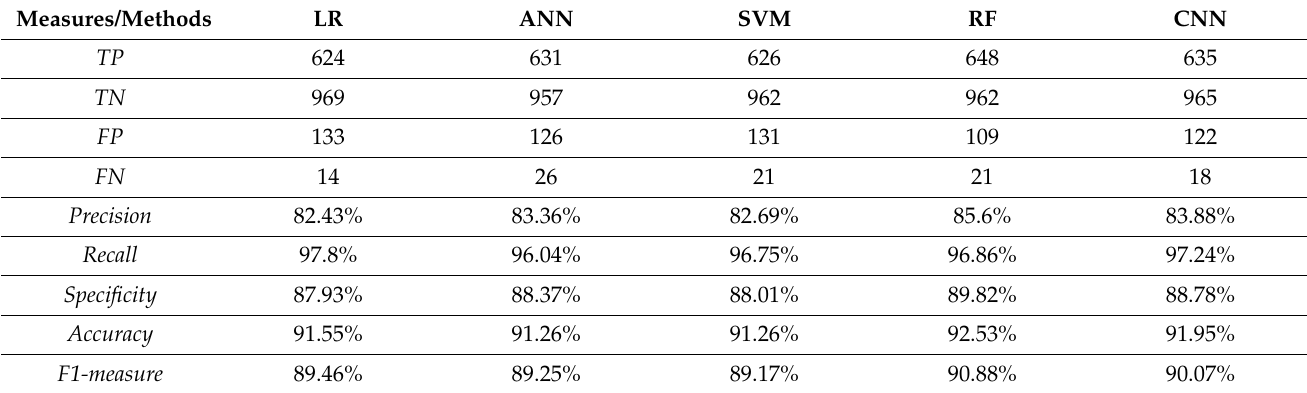
Table 2. The performance of five employed methods in the terms of evaluation